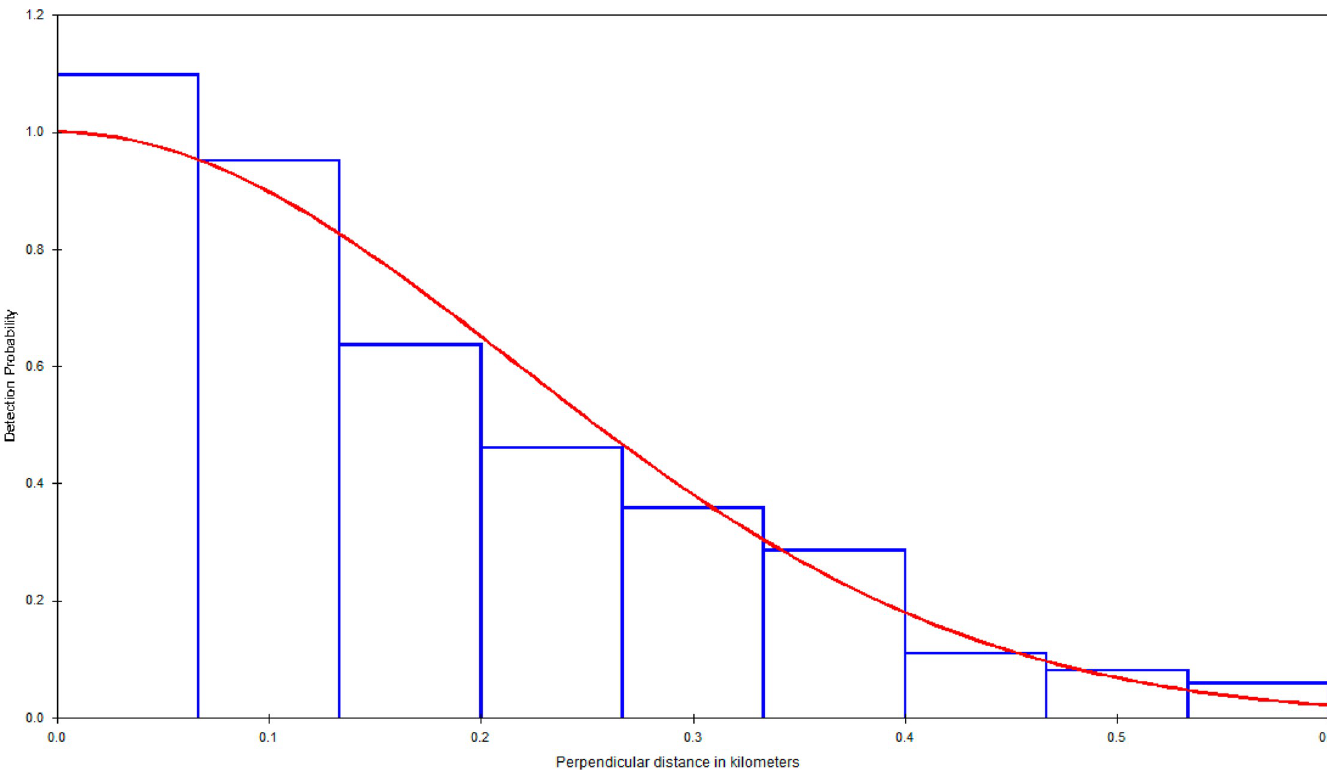
Fig 5. Perpendicular sighting distance histogram and fitted detection function (using a Half-Normal model with cosine adjustment), Hood Canal.